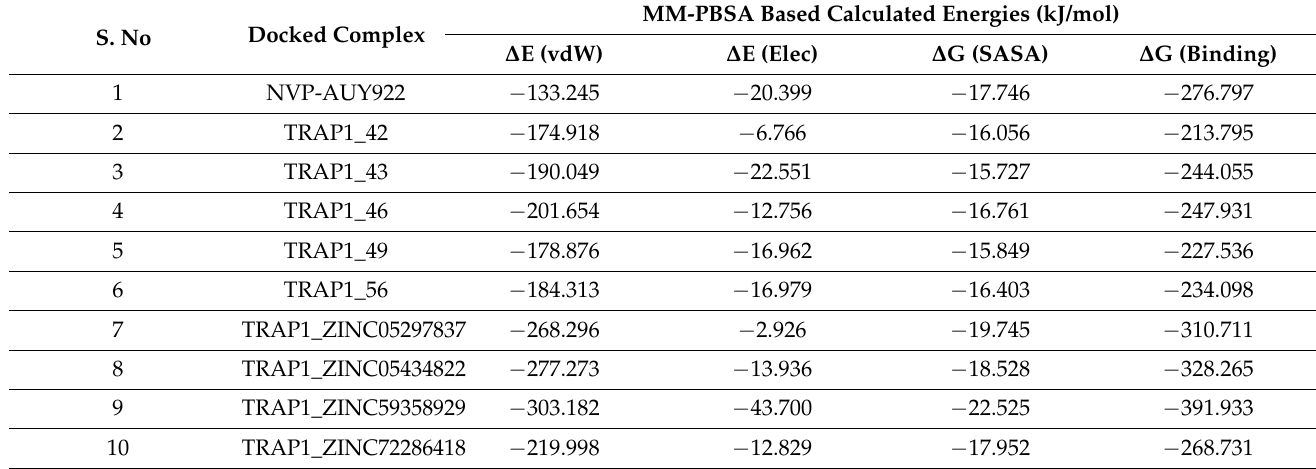
Table 7. The list of attributes associated with the free energy of binding between the TRAP1 and studied inhibitors. S.